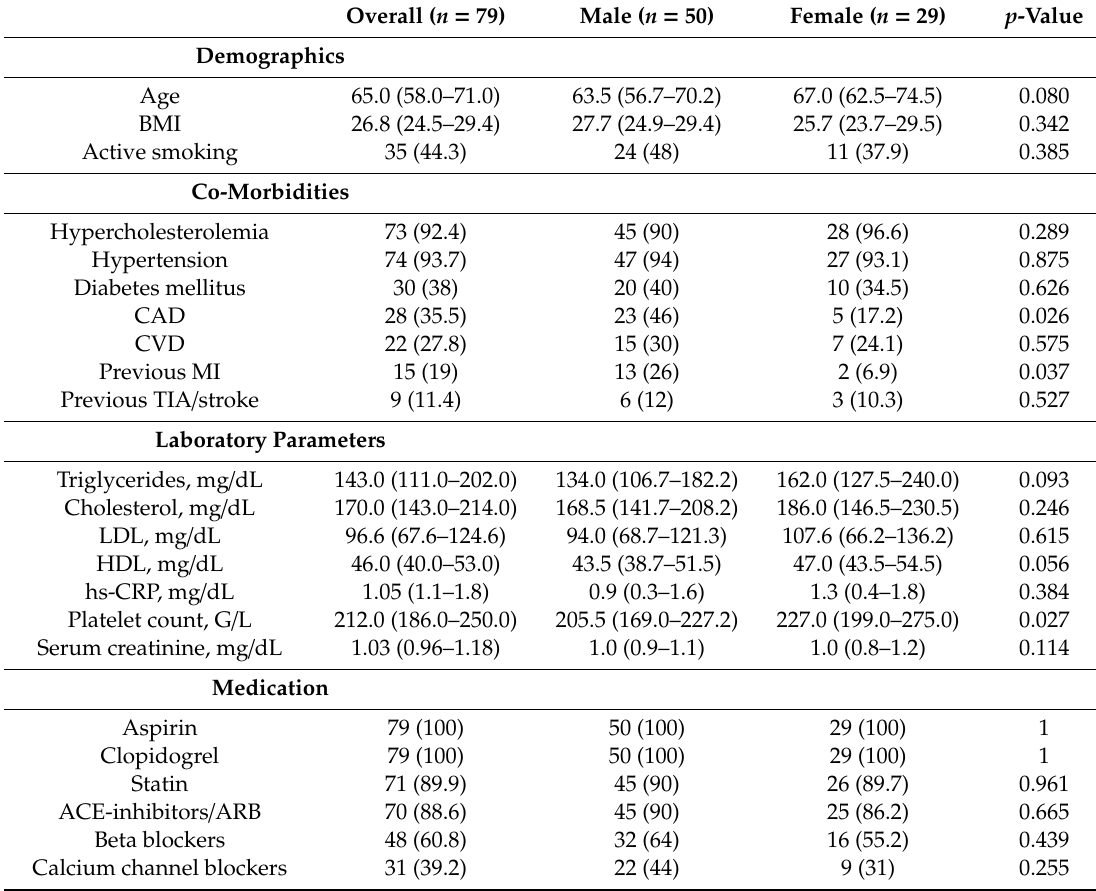
Table 1. Patient characteristics.